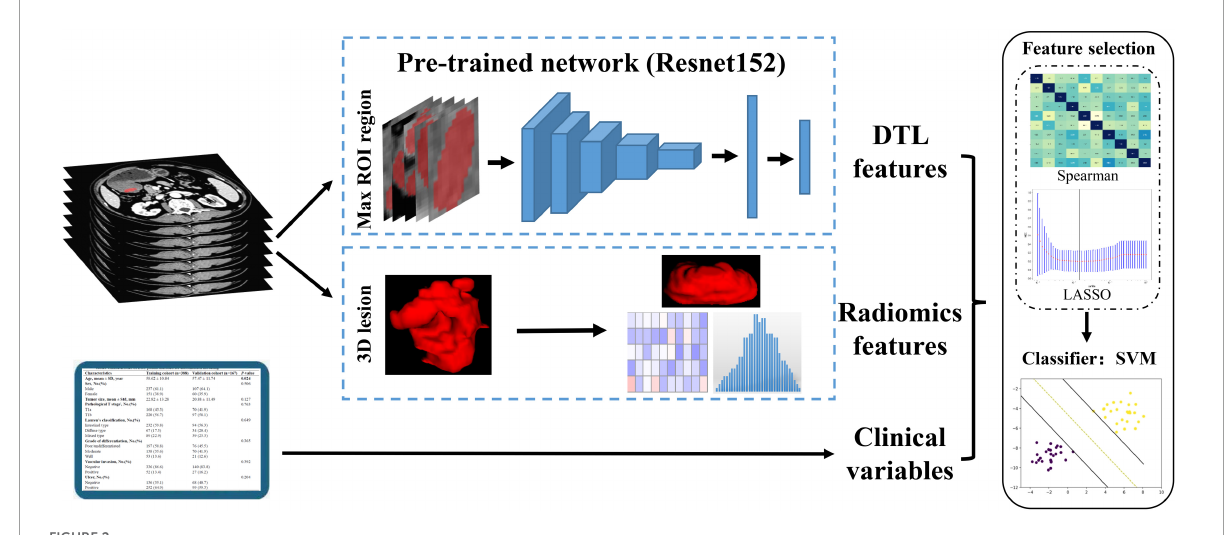
FIGURE2 Workflow of model development. DTL, deep transfer learning; ROI, regions of interest.